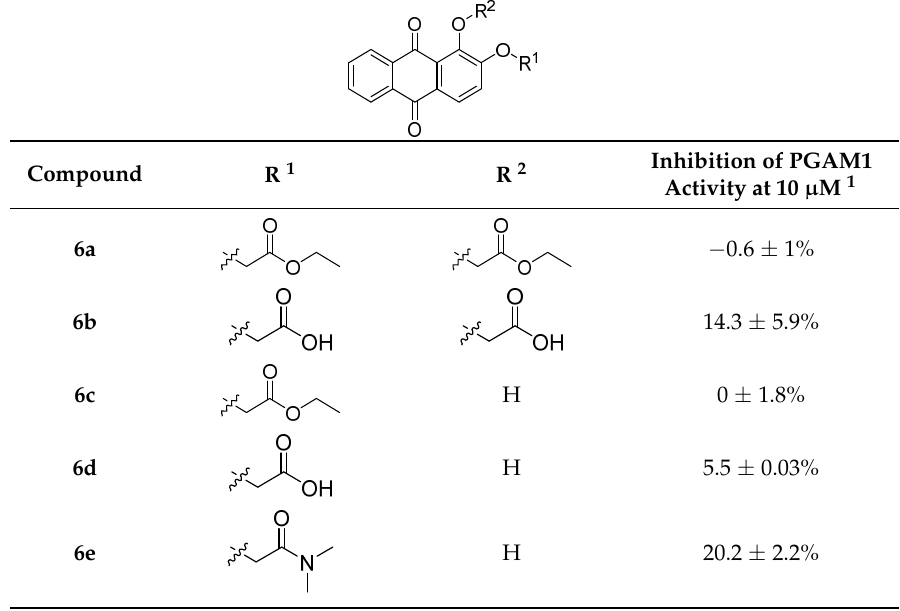
Table 1. Inhibition activity of compounds 6a – e towards PGAM1 .